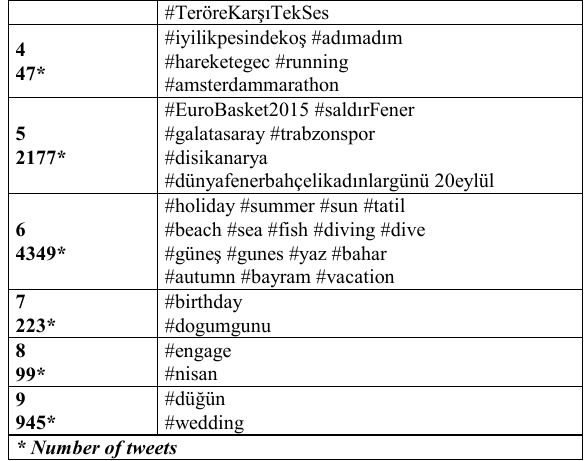
Table 2. Tweets Hashtag Keywords